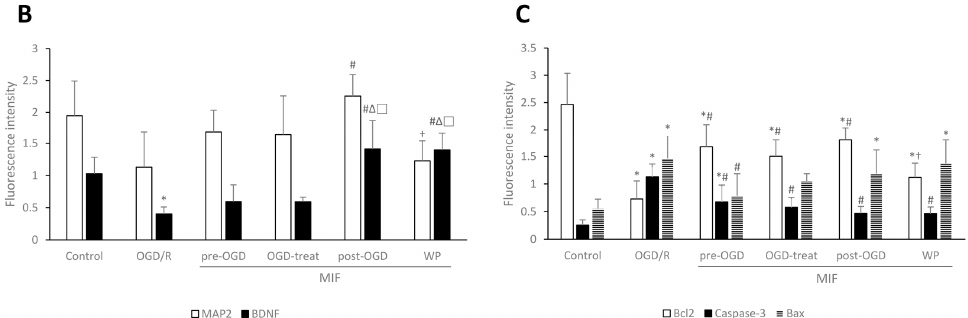
Figure 7. Immunocytochemistry findings of MAP2, BDNF, Bcl-2, Caspase-3, and Bax levels under control, OGD/R, and OGD/R conditions administered with MIF at different times. ( A ) Representative images of immunocytochemistry for each group; ( B , C ) the expression of MAP2 and BDNF were higher in the post-OGD group than in the OGD/R group. The expression of Bcl-2 was higher in the MIF groups than in the OGD/R group, and Caspase-3 and Bax expression was lower in the MIF groups than in the OGD/R group. Mean ± SD values are presented. * p < 0.05 vs. control; # p < 0.05 vs. OGD/R group; ∆ p < 0.05 vs. pre-OGD group; □ p < 0.05 vs. OGD-treat group; † p < 0.05 vs. WP group. Differences between groups were analyzed using one-way ANOVA followed by Tukey’s post hoc test (number of independent cell culture experiments ( n ): all, n = 6) (scale bar, 20 µ m; magnification, 400 × for MAP2 and Caspase-3, or 630 × for BDNF, Bcl-2, and Bax). These results indicate that MIF administered during reperfusion (post-OGD group) is the most effective at inducing BDNF expression; however, the effects of administration